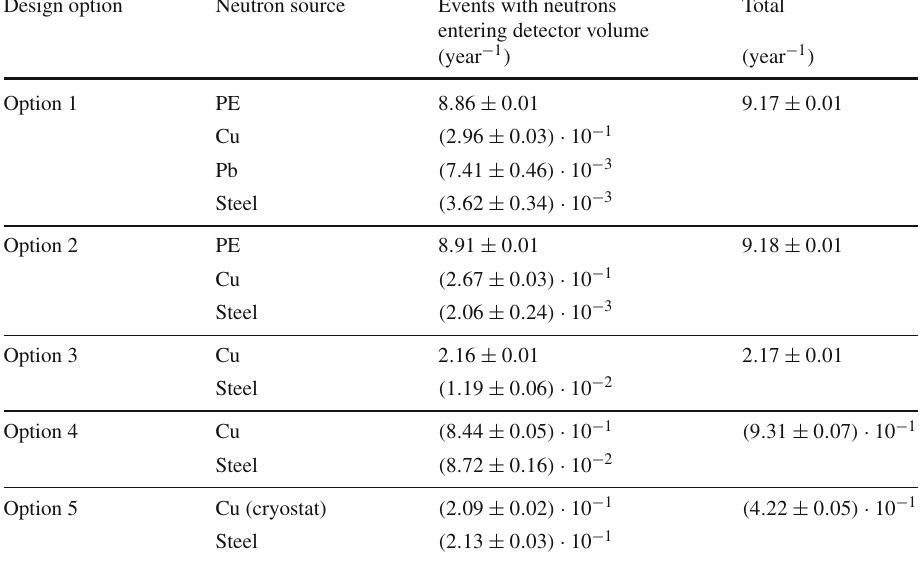
background contributions originating from distinct materials used in the various design options. Stated